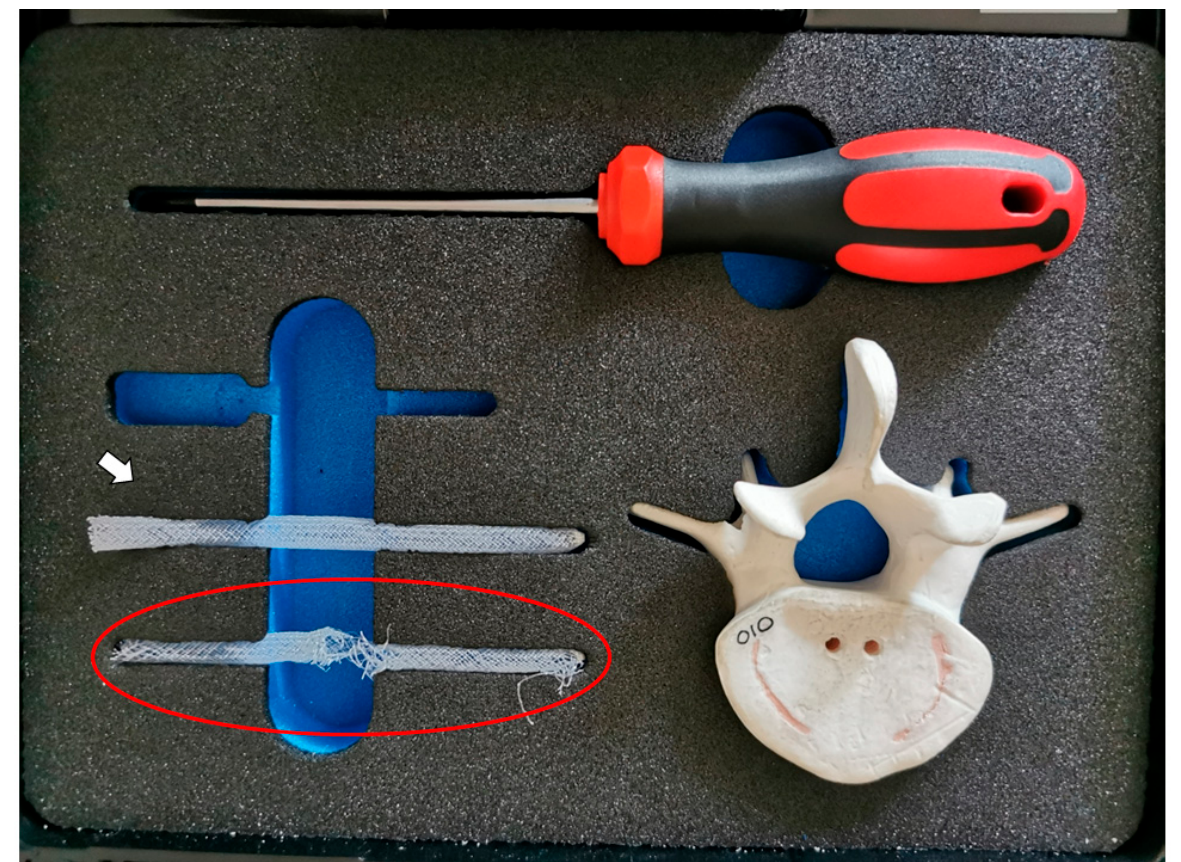
Figure 3. An example of an OGmend ® kit with an intact sleeve implant (white arrow) and a de- interlaced one (red circles) showing the net of interwoven polyethylene terephthalate fibers. After selecting the appropriate screw length, we partially cut the sleeve with